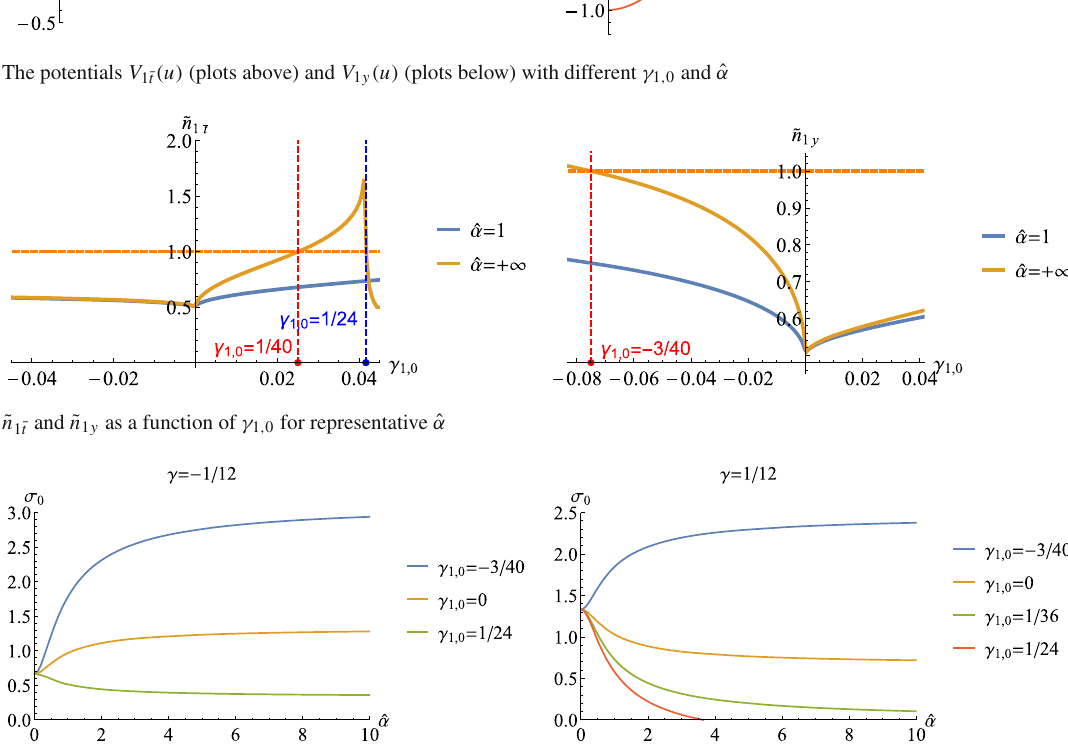
region γ 1 , 0 < − 3 / 40 and 1 / 40 < γ 1 , 0 < 1 / 24, the ˜ n 1 i